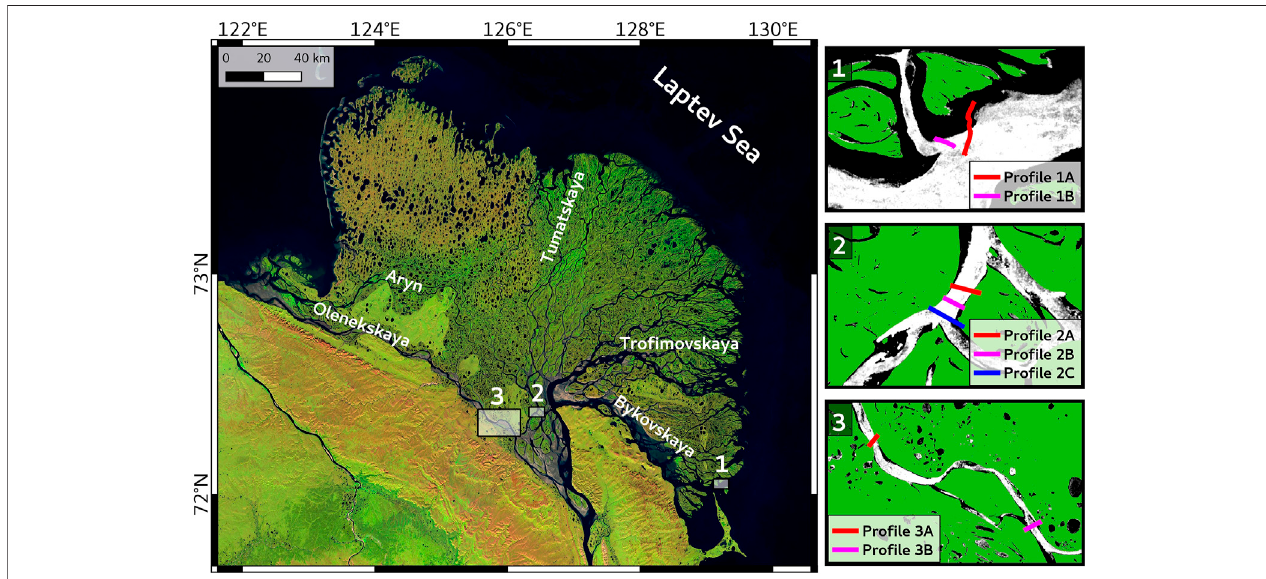
FIGURE 1 | Mosaic of Landsat 8 OLI images (generated in Google Earth Engine) of the Lena River Delta with its numerous river channels. Three sites with in situ electrical resistivity tomography (ERT) pro fi les are shown in the inset maps with the synthetic aperture radar (SAR) winter backscatter image (median of several years) in the background and a land mask (green).